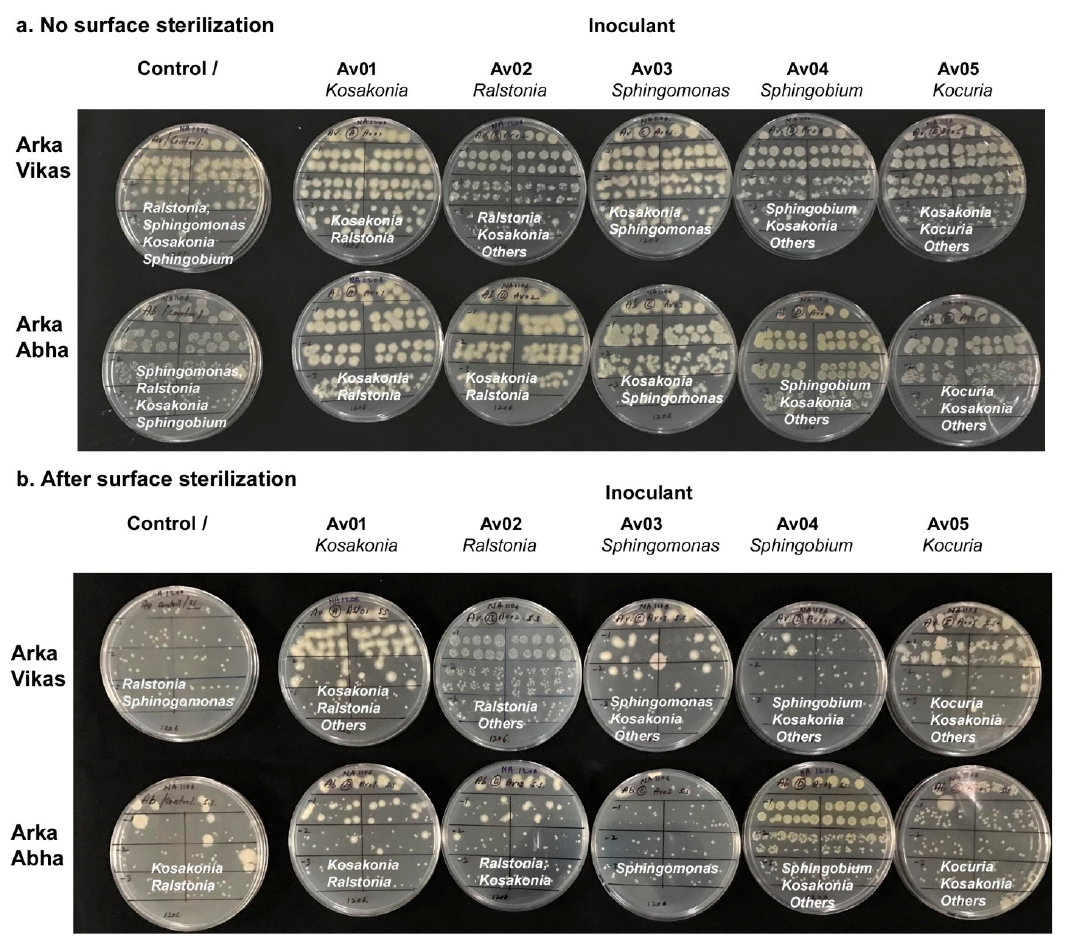
Figure 5. Testing the re-colonization efficacy of endophytic bacterial isolates through seed soaking inoculation of surface sterilized seeds of tomato “Arka Vikas” with single “Arka Vikas” isolates Tm-Vt-SE-Av01 to Av05. ( a ) Monitoring the root tissues of in vitro seedlings after two weeks of seed inoculation without surface sterilization, and ( b ) after surface sterilization using NaOCl, displaying the association of multiple organisms in uninoculated control and the inoculant plus additional organisms in the seed inoculated